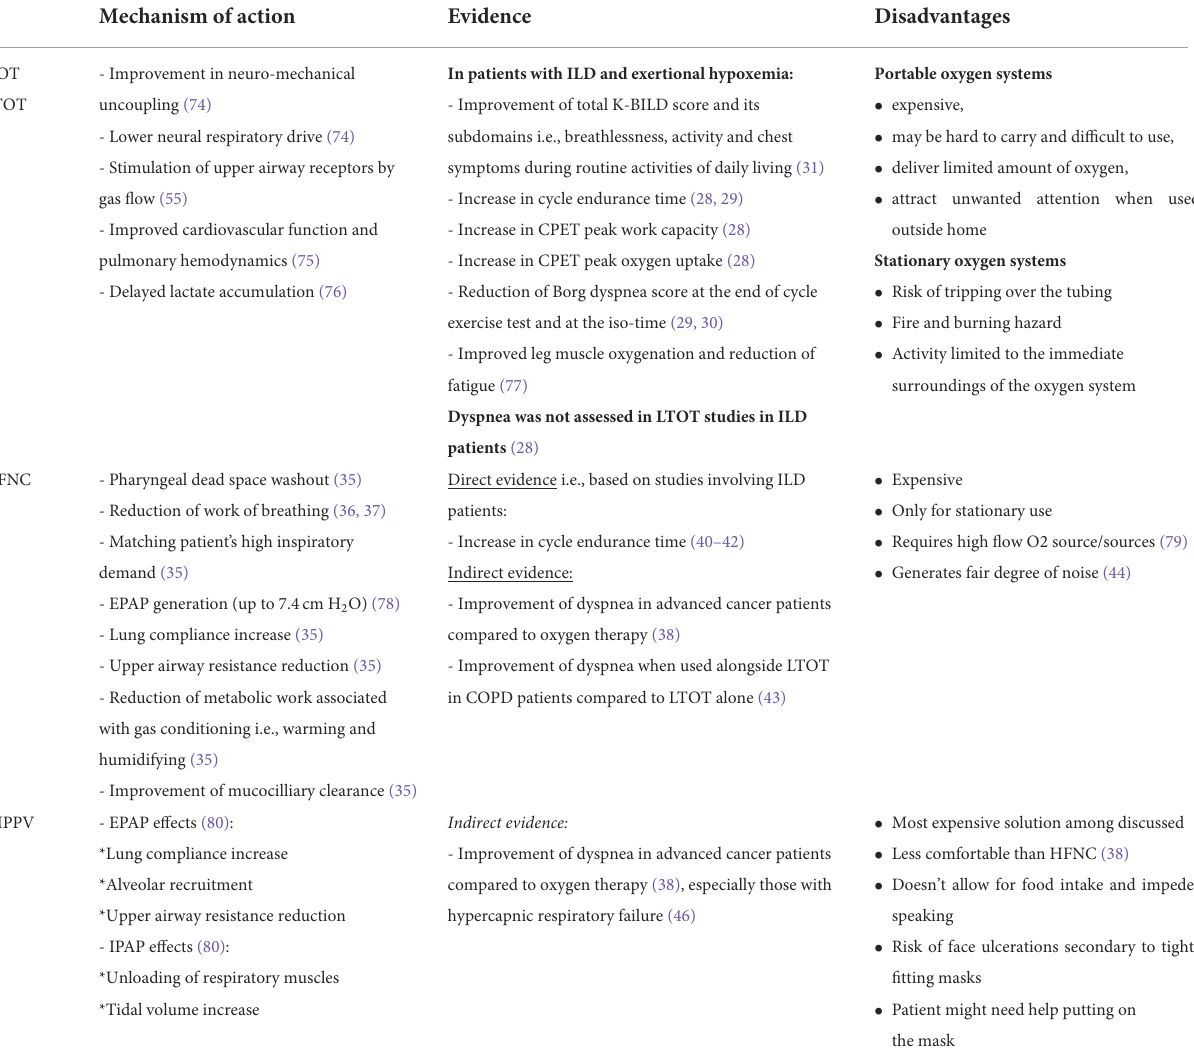
TABLE 1 Types of oxygen therapy and ventilatory support and their potential in treating breathlessness in IPF patients. Mechanism of